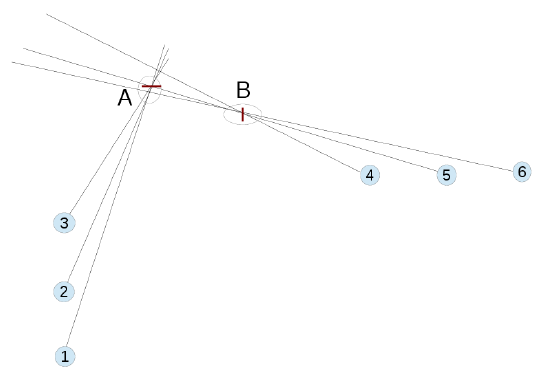
Figure 1: Clustering ambiguity: Two 3D signs (A, B) and six 2D detections (1-6). The correct clustering is (1,2,3) (4,5,6) but a greedy approach will usually give (1,2,3,5,6) (4) leading to a poor reconstruction of sign A and an omission of sign B that cannot be reconstructed from a single